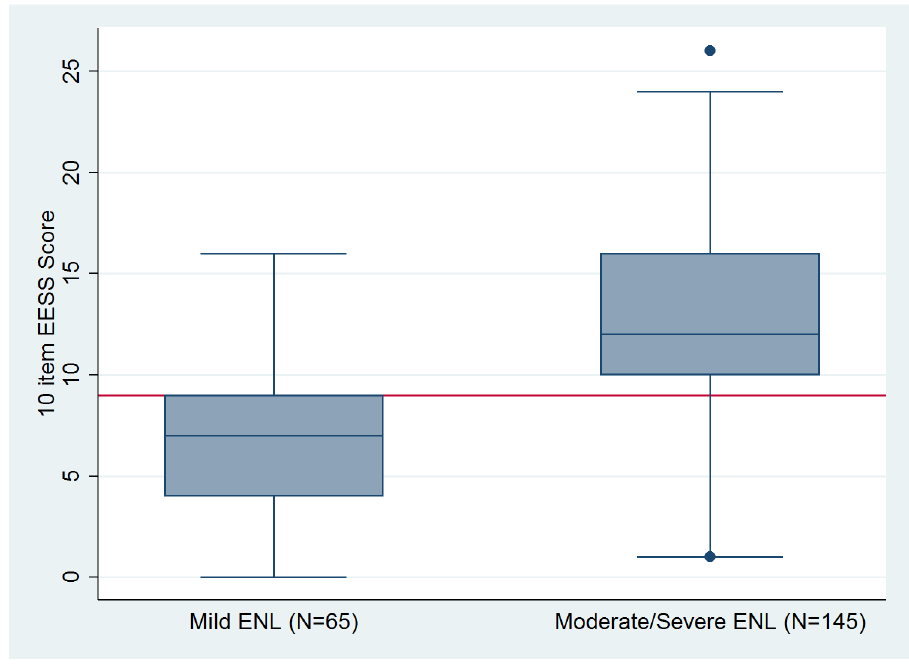
Fig 4. Box plot of 10 item EESS scores for mild compare with moderate and severeENL. The line in red indicatesthe cut off betweenmild ENL and more severe disease.